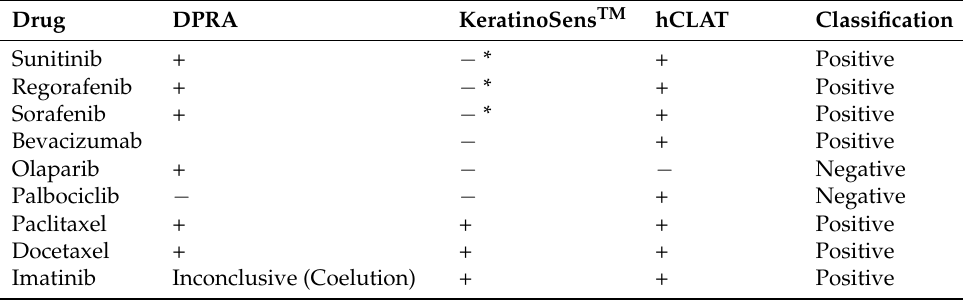
Figure 1. Analysis of delayed-type hypersensitivity of paclitaxel and docetaxel by direct peptide reactivity assay (DPRA), KeratinoSens TM assay, and human cell line activation test (hCLAT). ( A ) DPRA analysis 24 after incubation with pacliaxel. Results are expressed as a percentage of cysteine depletion. ( B ) KeratinoSens TM analysis after 48 h of incubation with paclitaxel. Results are expressed as luciferase activity (Imáx). ( C ) % of viability after 48 h of incubation with paclitaxel. ( D ) Human cell line activation test (hCLAT) analysis after 48 h of incubation with paclitaxel. Results are expressed as relative fluorescence intensities of CD86 and CD54. ( E ) DPRA analysis 24 h after incubation with docetaxel. Results are expressed as a percentage of cysteine depletion. ( F ) KeratinoSens TM analysis after 48 h of incubation with docetaxel. Results are expressed as luciferase activity (Imáx). ( G ) % of viability after 48 h of incubation with docetaxel. ( H ) hCLAT analysis 48 h of incubation with docetaxel. Results are expressed as relative fluorescence intensities of CD86 and CD54. Lactic acid (LA), 6-Methylcoumarin, and isopropanol were used as negative controls. 1-chloro-2,4-dinitrobenzene (DNCB), cinnamic aldehyde (CA), and nickel sulfate (NS) were used as positive controls. Shown are mean ± SEM ( n = 3). The dashed line depicts the minimum positive stimulation index. Table 1. Classification results for antineoplastics.